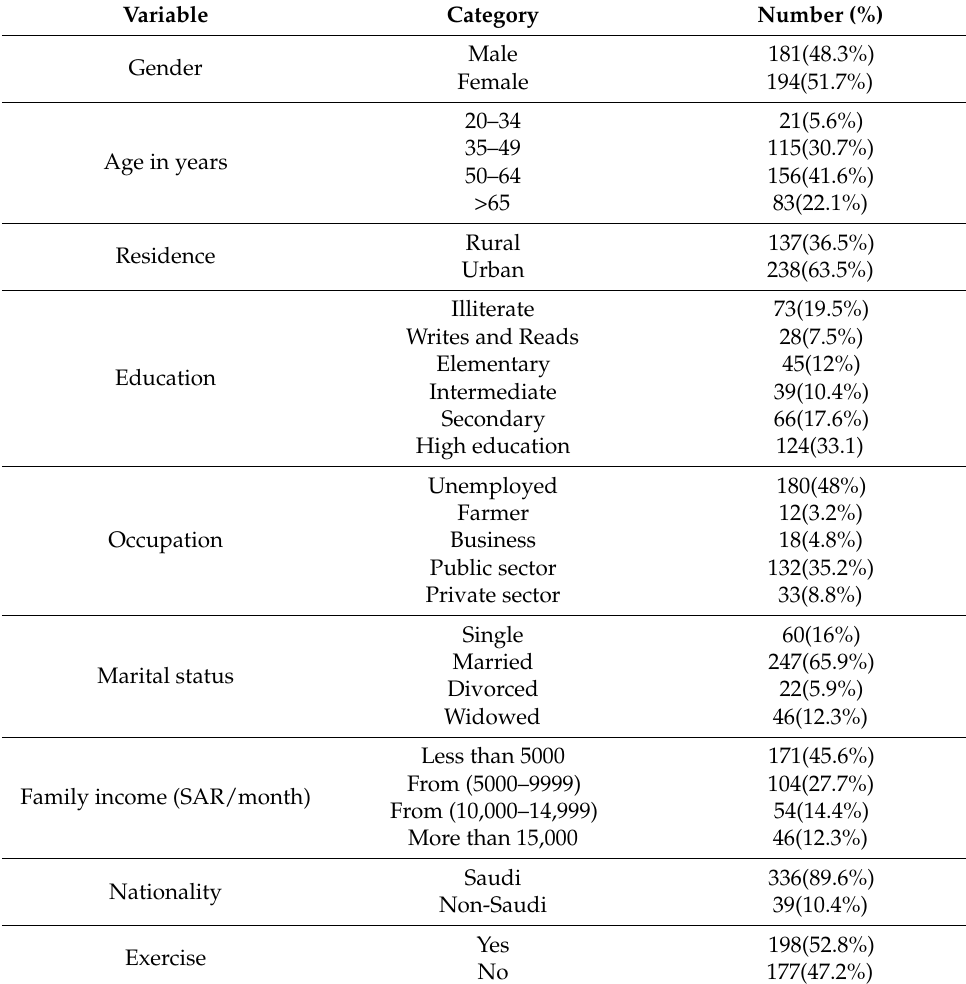
Table 1. Demographic characteristics of participants ( n =